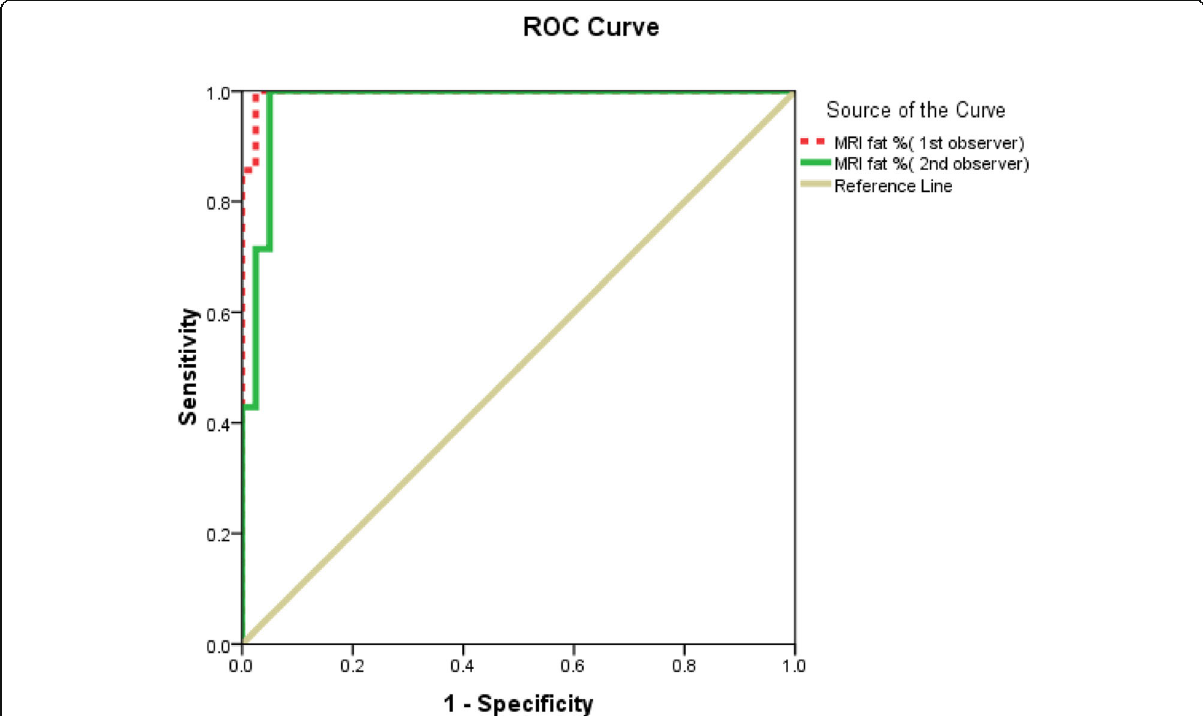
Fig. 2 ROC curve demonstrating the diagnostic accuracy of MR hepatic proton density fat fraction technique in estimation of hepatic steatosis